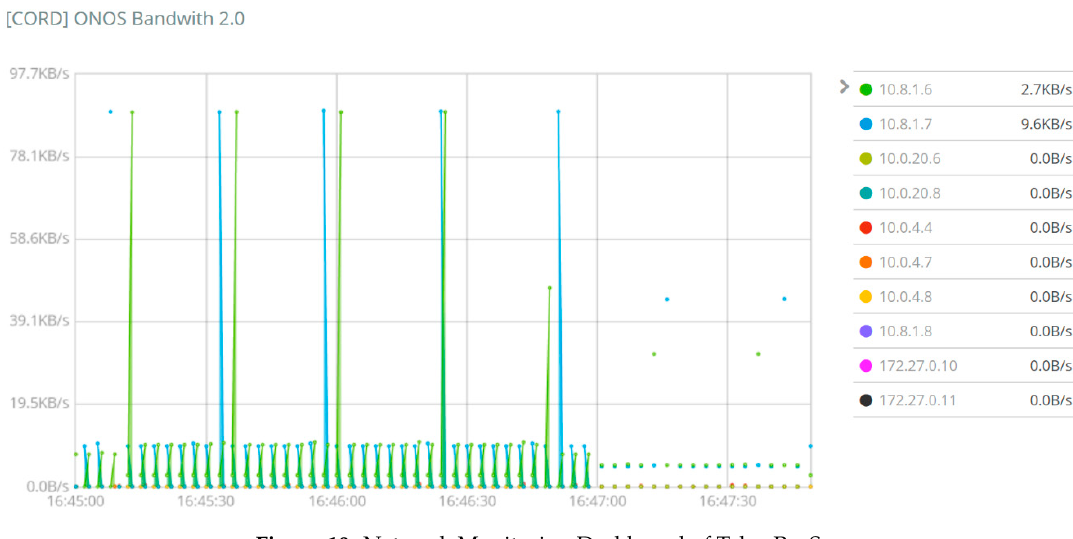
Figure 10. Network Monitoring Dashboard of Telco PaaS.